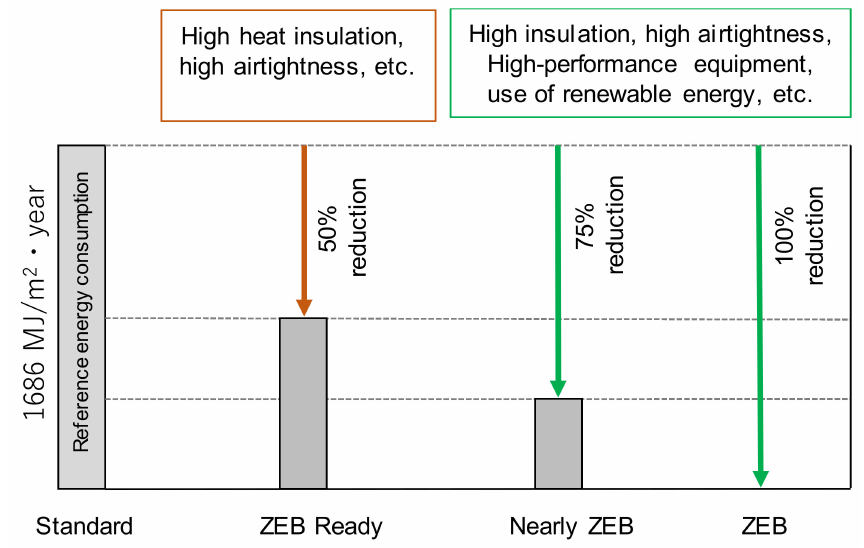
Figure 1. The structure of ZEB in Japan.